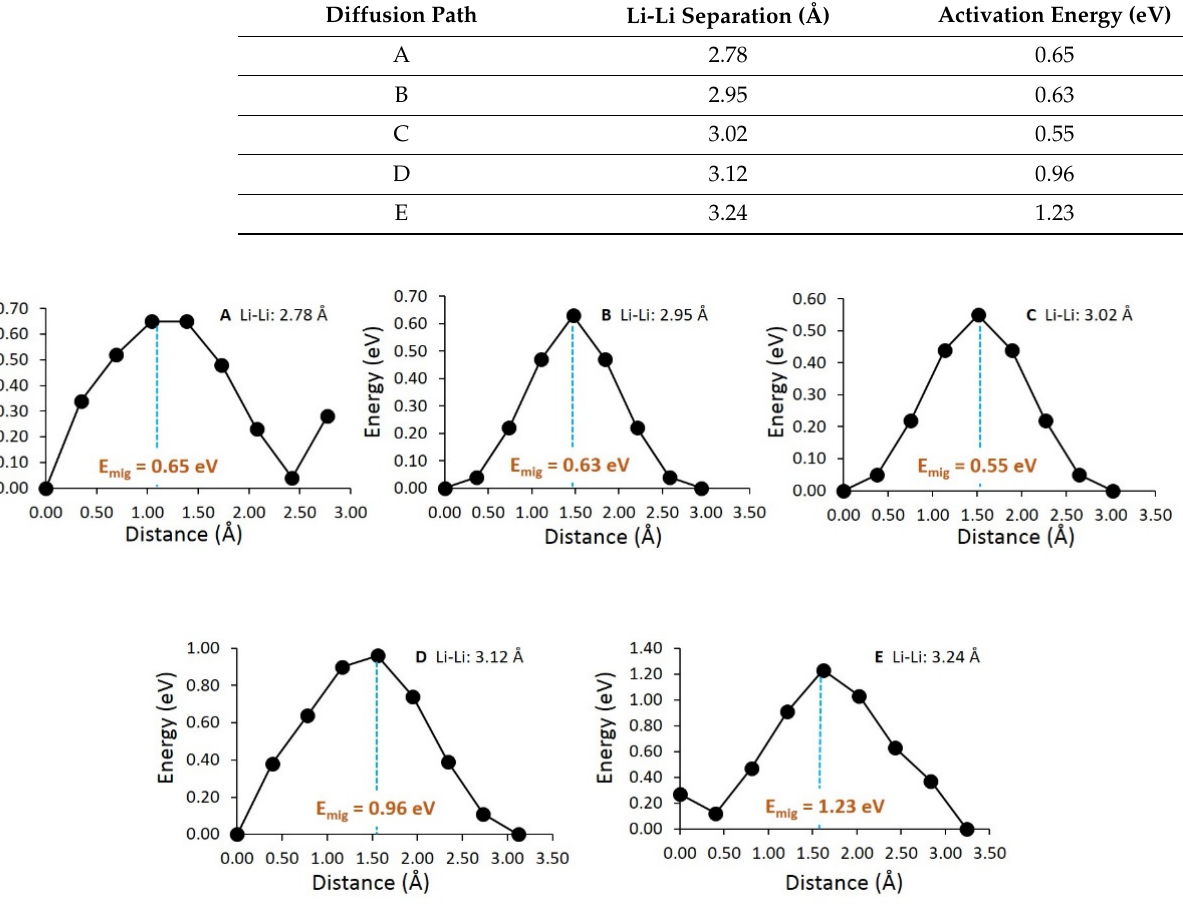
Figure 3. Energy profile diagrams for local Li hop activation energies. Letters ( A – E ) are local Li hops as shown in Figure 2.